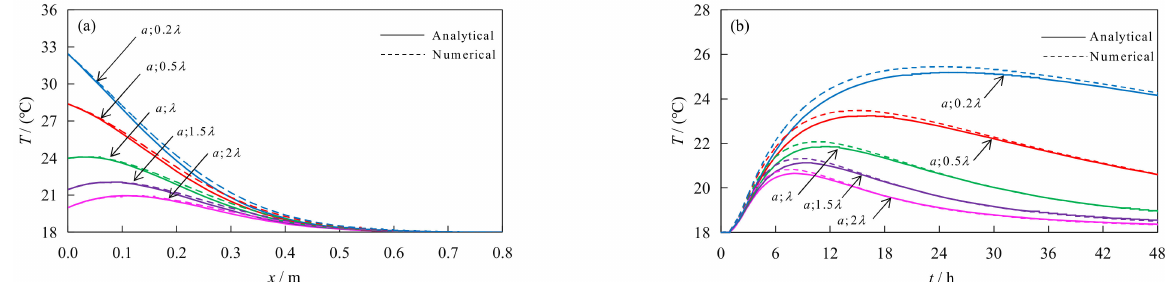
Figure 3. ( a ) Comparison of temperature in the presence of temperature source for different thermal diffusivity values with fixed coefficient of cooling ratio at t = 11 h. ( b ) Variation of temperature profiles in the presence of temperature source at x = 0.2 m. The analytical and numerical solutions are shown as solid and dotted lines, respectively.